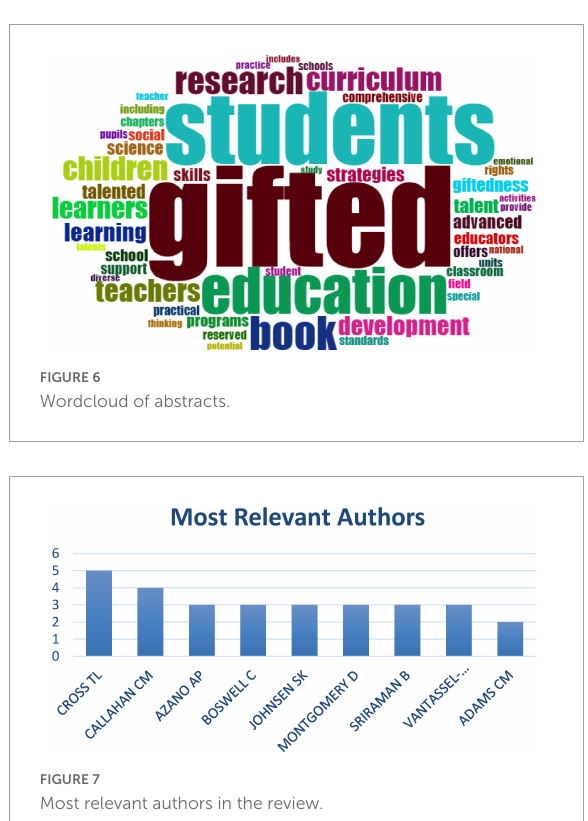
FIGURE7 Most relevant authors in the